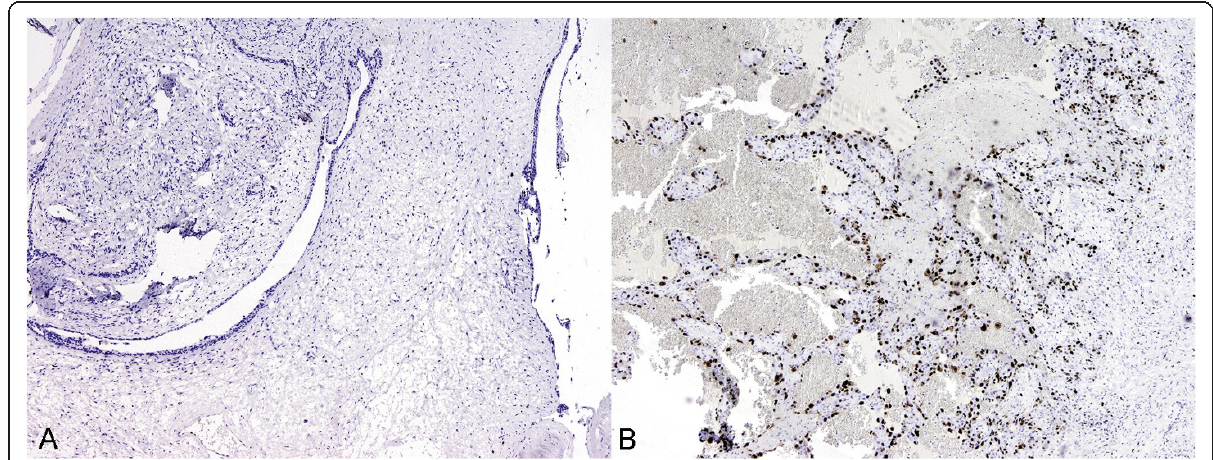
Figure 3 Immunohistochemical staining with monoclonal antibody Ki-67/MIB-1 . Ki-67 proliferative activity in fibroadenoma, 40 × (A); and in angiosarcoma, 40 ×